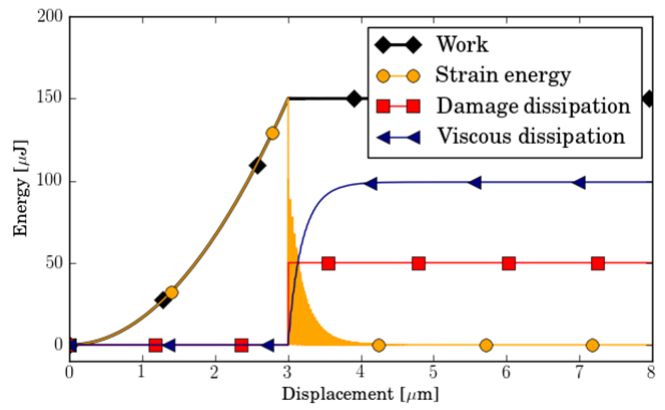
Fig. 4 Evolution of energies in function of displacement for unit element model with immediate